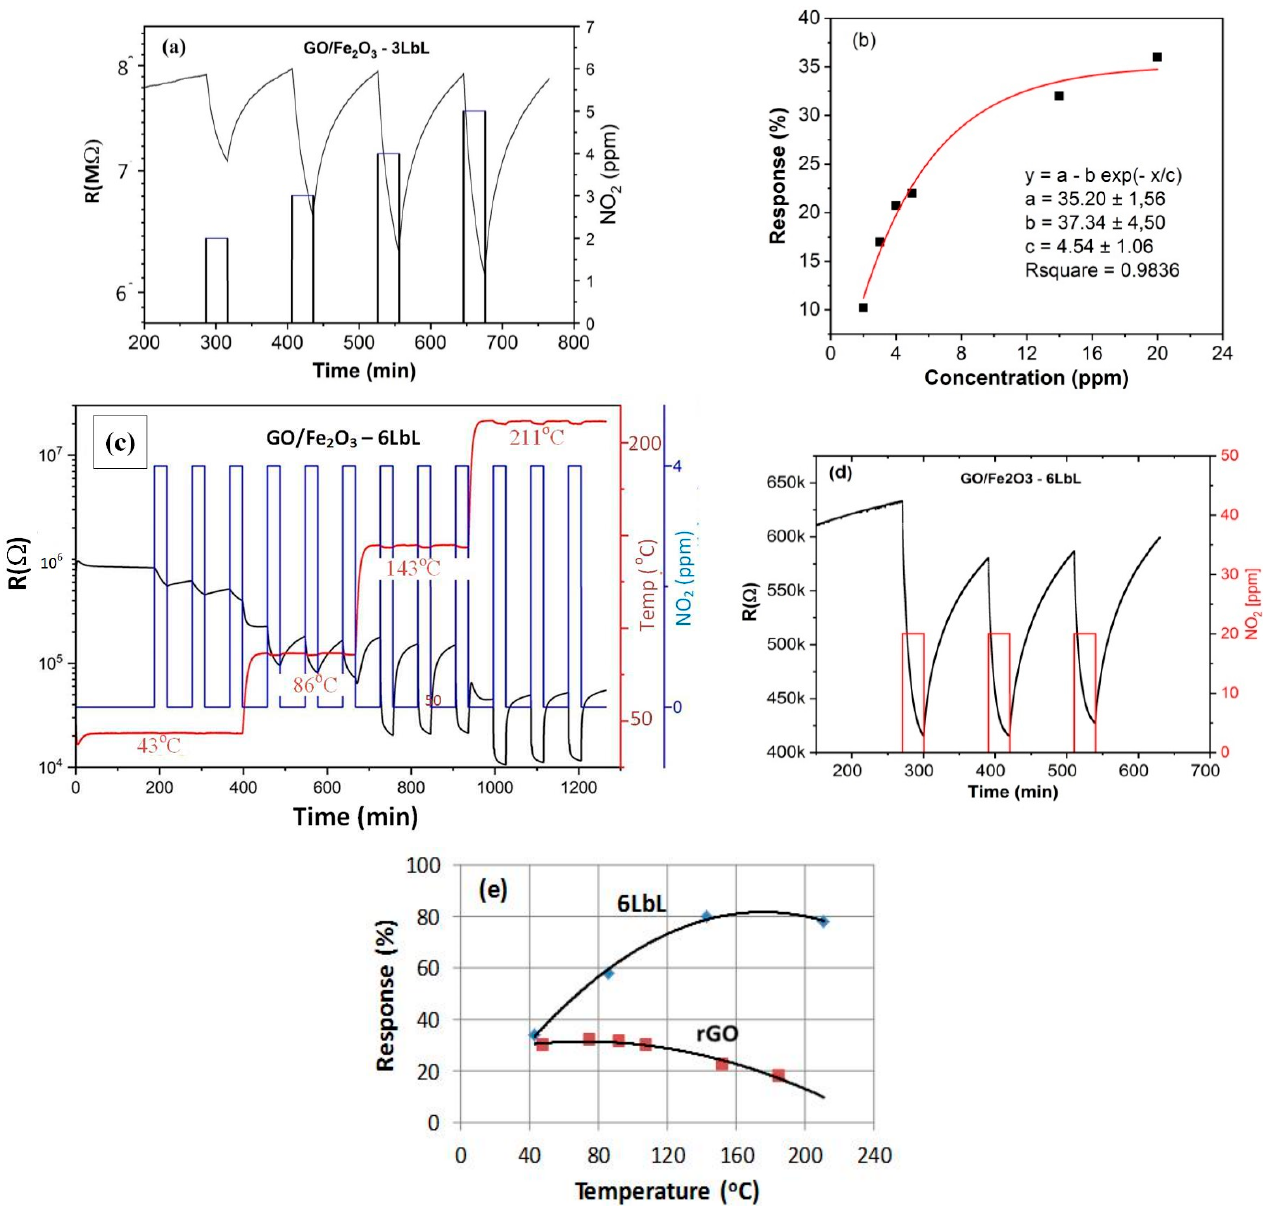
Figure 6. ( a ) Variation of resistance with time for GO/Fe 2 O 3 3LbL structure with increasing NO 2 concentration at the temperature of 30 °C with a calculated response of this structure for increasing NO 2 concentration ( b ); ( c ) variation of resistance for GO/Fe 2 O 3 6 LbL structure with changing sensor temperature at 4 ppm NO 2 and ( d ) at 20 ppm NO 2 at a constant temperature 30 °C; ( e ) comparison of responses for samples GO/Fe 2 O 3 6 LbL and single rGO layer with increasing measurement temperature at 4 ppm NO 2 .